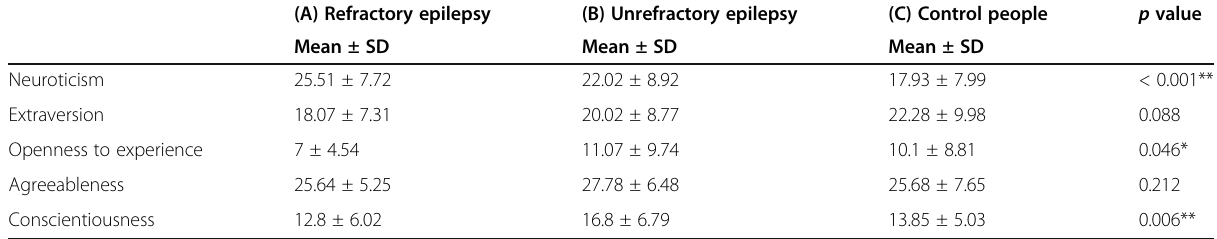
Table 4 Comparison between the studied sample groups regarding five-factor model (A) Refractory epilepsy (B) Unrefractory epilepsy (C) Control people p